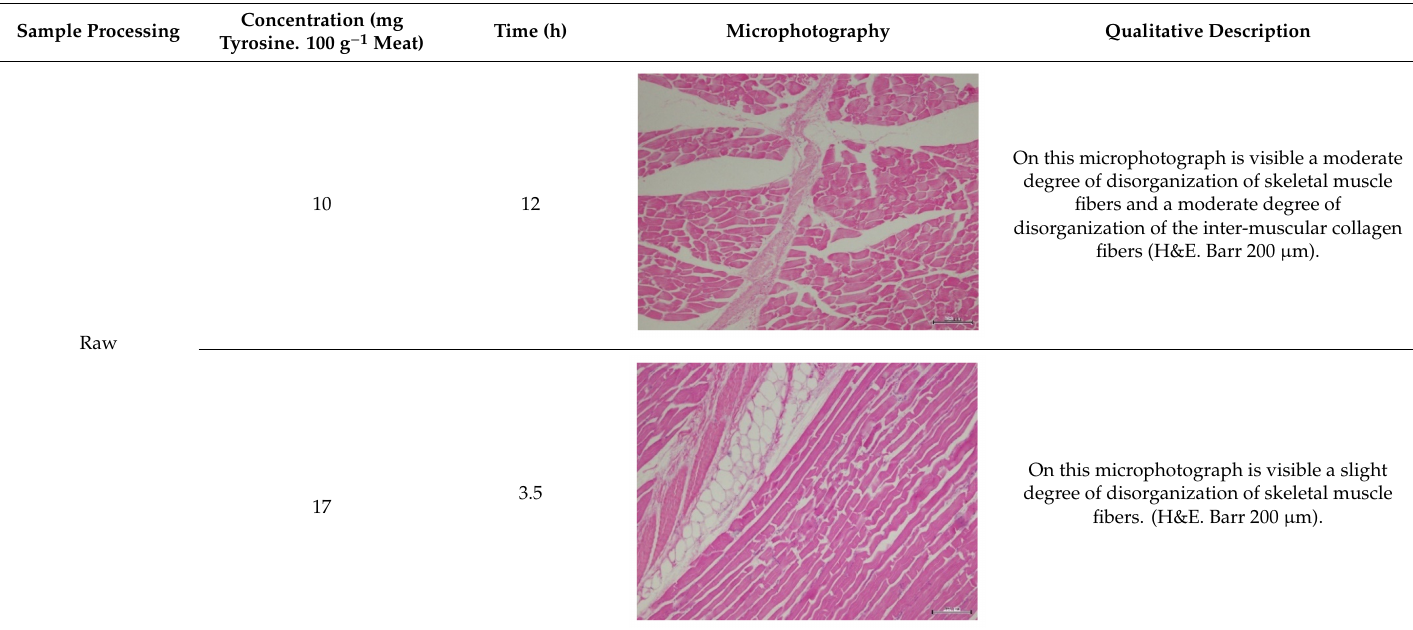
Table 3. Histological technique images collected through optical microscope with digital camera as a function of marinades and cooking: bromelain concentration (mg tyrosine.100 g − 1 meat) and time